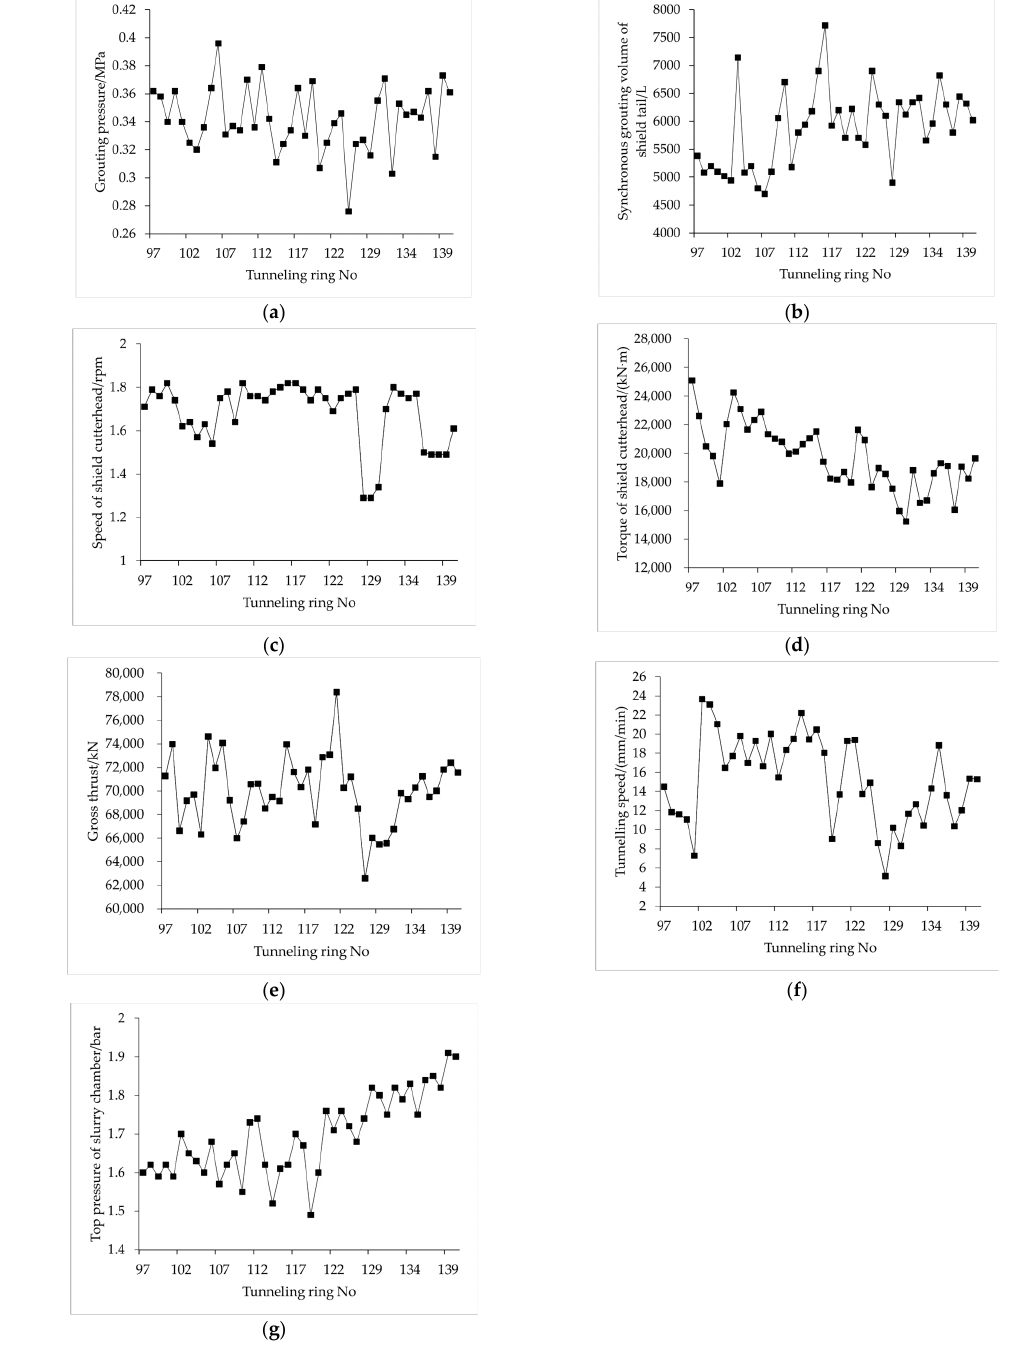
Figure 7. Main tunneling parameters of the monitoring section: ( a ) grouting pressure; ( b ) synchronous grouting volume; ( c ) speed of shield cutterhead; ( d ) torque of shield cutterhead; ( e ) gross thrust; ( f ) tunneling speed; ( g ) top pressure of slurry